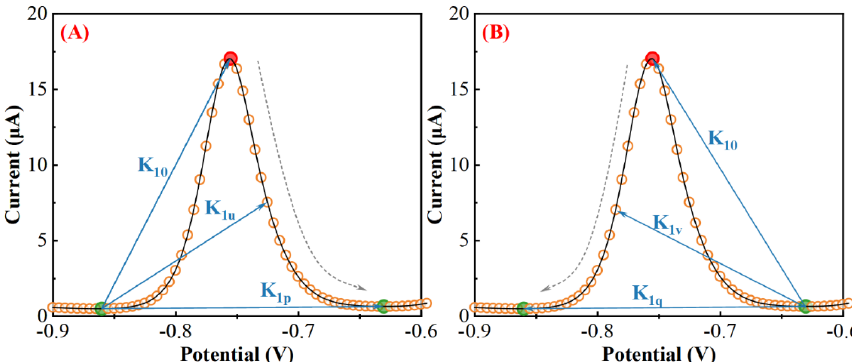
Figure 2. Schematic representation of the calculation of valid data segments ( A , B ). (The i -th segment of the SWASV response curve for 150 μg/L Zn 2+ , 35 μg/L Cd 2+ , 175 μg/L Pb 2+ , 300 μg/L Bi 3+ , and 100 μg/L Cu 2+ ).